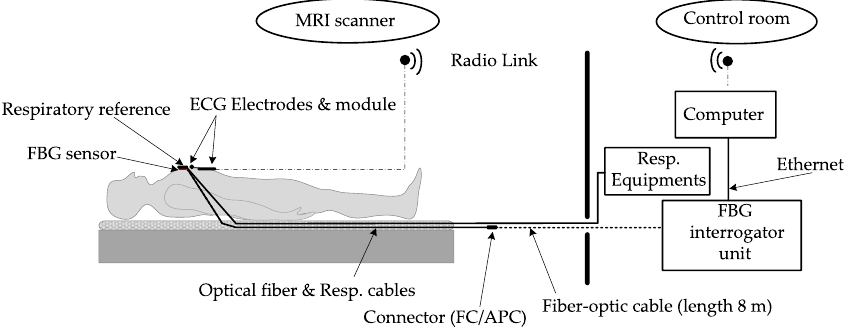
Figure 8. Positioning of the FBG sensor on the human body and the experimental